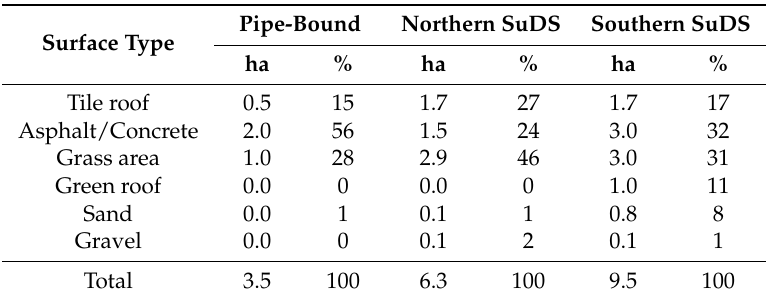
Table 1. Distribution of different types of surfaces in the catchments in Augustenborg extracted from Reference [21].